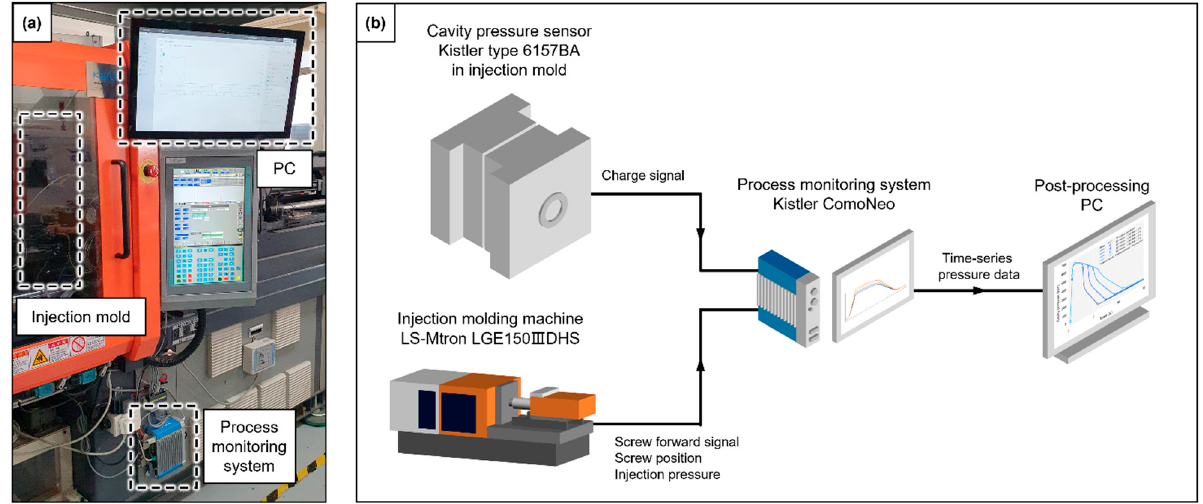
Figure 4. Process monitoring system setup ( a ) overall setup, and ( b ) signal connections.